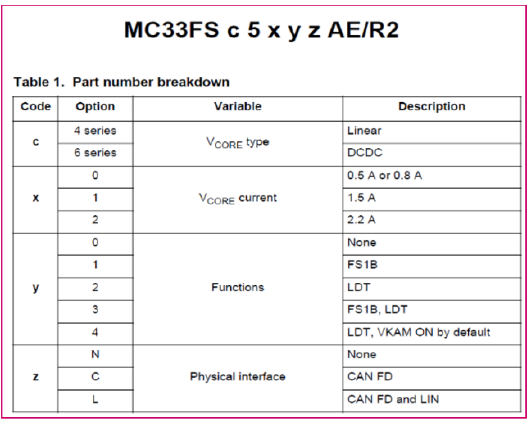
Figure 2. SBC (NXP) component nomenclature. Reproduced from [1].